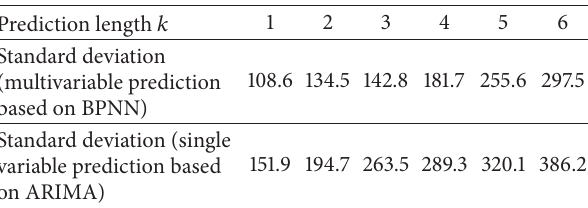
Table 2: The error variances of icing load prediction in same icing process for the first serious icing process from (12/17/2009 ∼